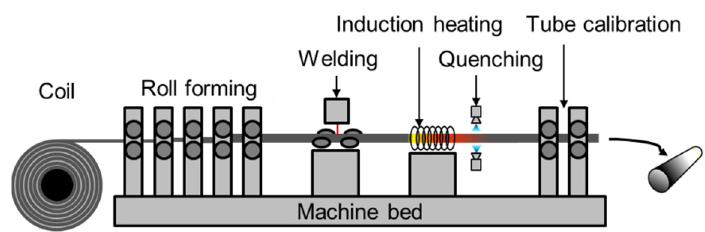
Figure 1. Tube forming process chain with an inline heat treatment process.